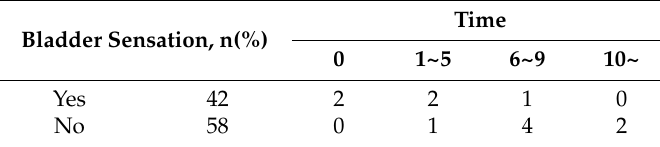
Table 4. Voided urine volume ≥ 550 mL per month ( n =